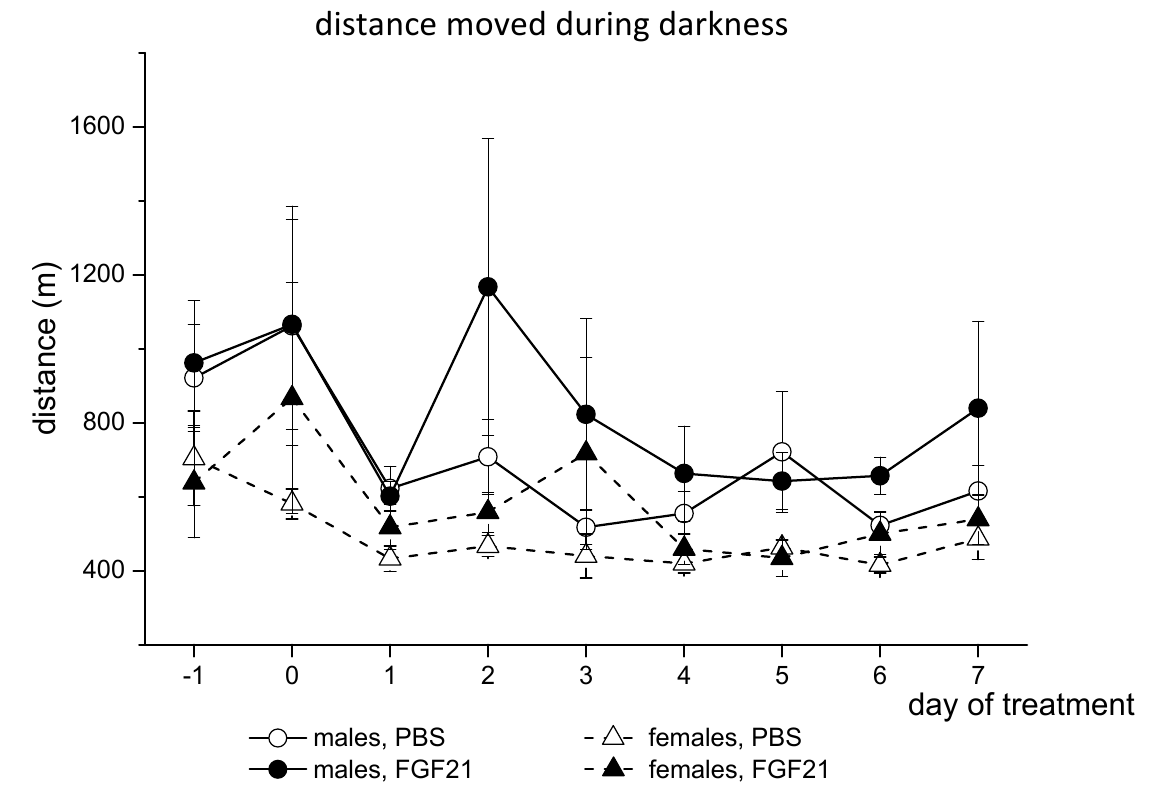
Figure 2. Influence of FGF21 administration on locomotor activity in obese A y male and female mice. Data are presented as mean ± SE. Mice were administered FGF21 for 7 days from day 0. Day “ − 1” is the day before the start of the experiment. Table 2. Influence of FGF21 administration on the masses of the body, fat, and liver in obese A y male and female mice. Results are presented as mean ± SE for the indicated number of mice. Data were analyzed with two-way ANOVA.